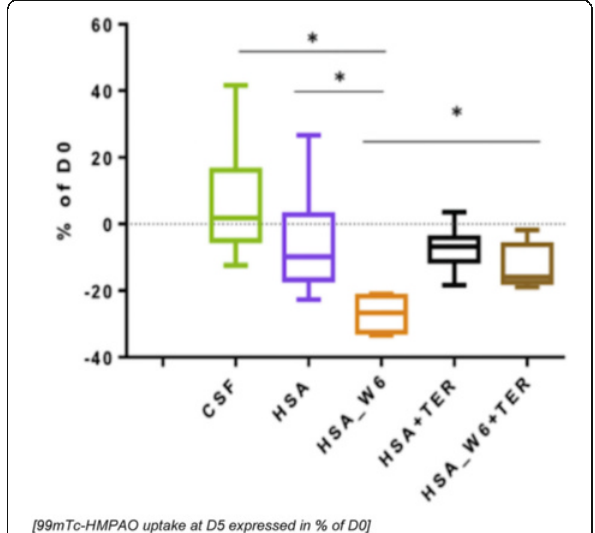
Fig. 49 (abstract A129). 99mTc-HMPAO uptake at D5 expressed in % of